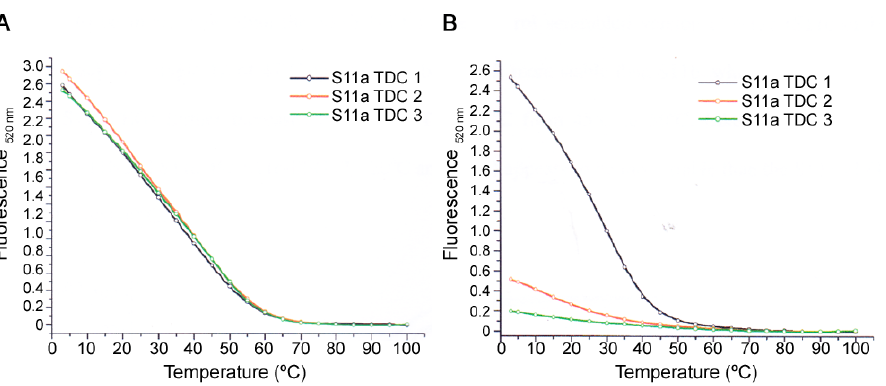
Figure 3. Thermal denaturation of S11a. ( A ) Fluorescence melting profiles of S11a alone at 3 TDC; ( B ) Fluorescence melting profiles of S11a with the 20mer peptide at 3 TDC.